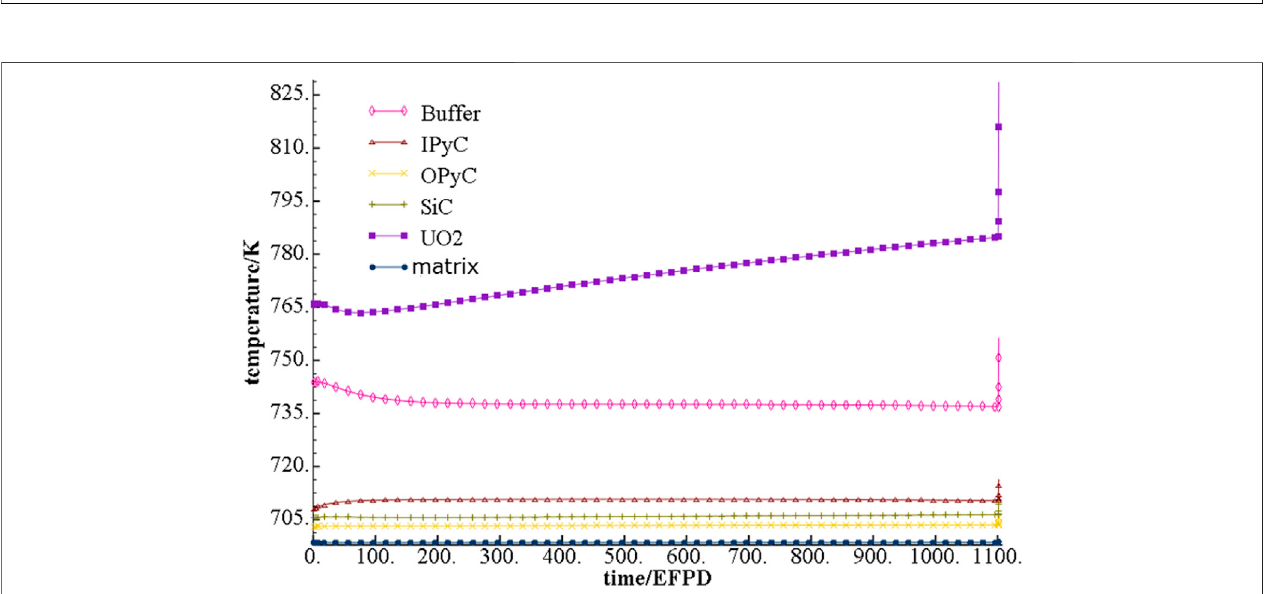
FIGURE 5 | Maximum temperature of each layer of material variation under steady operation condition and power transient condition.